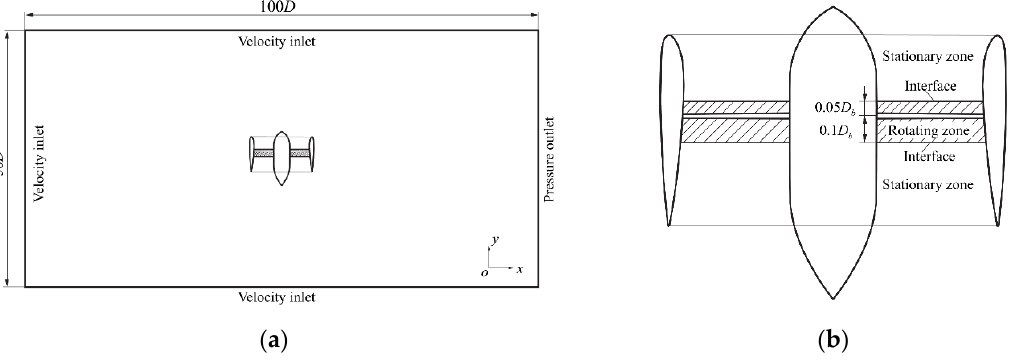
Figure 4. Computational domain and boundary conditions when out of ground effect: ( a ) boundary conditions; ( b ) computational domain divisions.